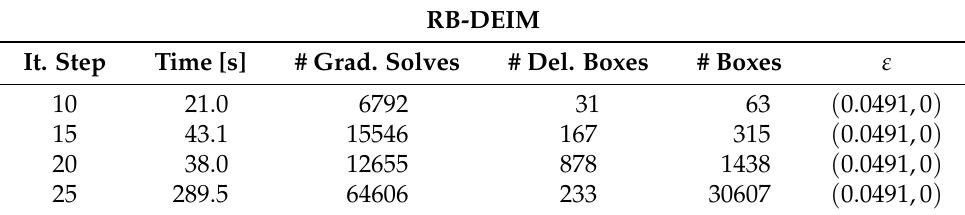
Table 3. Subdivision algorithm with the modified descent direction.